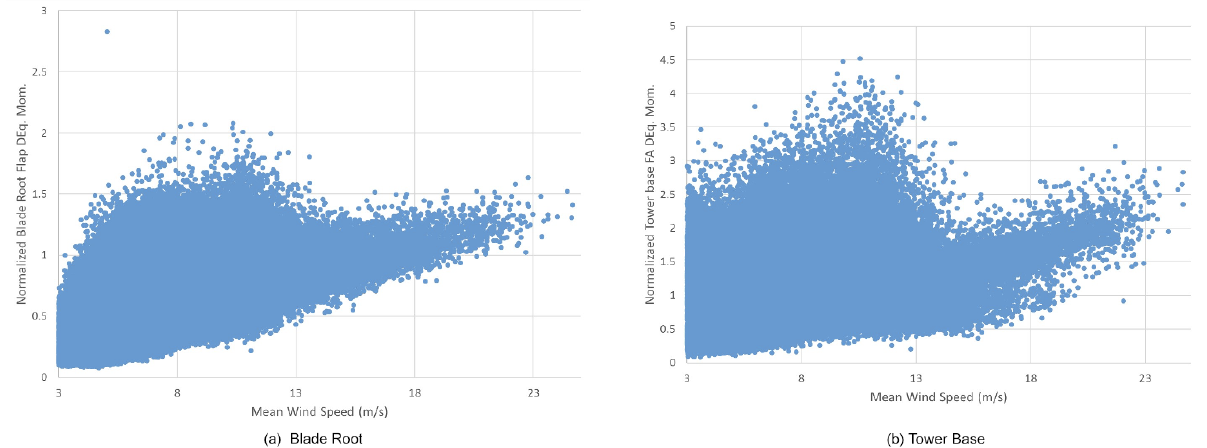
Figure 3. Measured 10min (a) blade root flap and (b) tower base fore–aft damage equivalent moments, on the C-08 turbine. The coefficient of variation (CoV) of blade root flap DELs below rated wind speed is 0.49 and above rated wind speed is 0.17. The CoV of tower base fore–aft (FA) DELs below rated wind speed is 0.47 and above rated wind speed is 0.29.